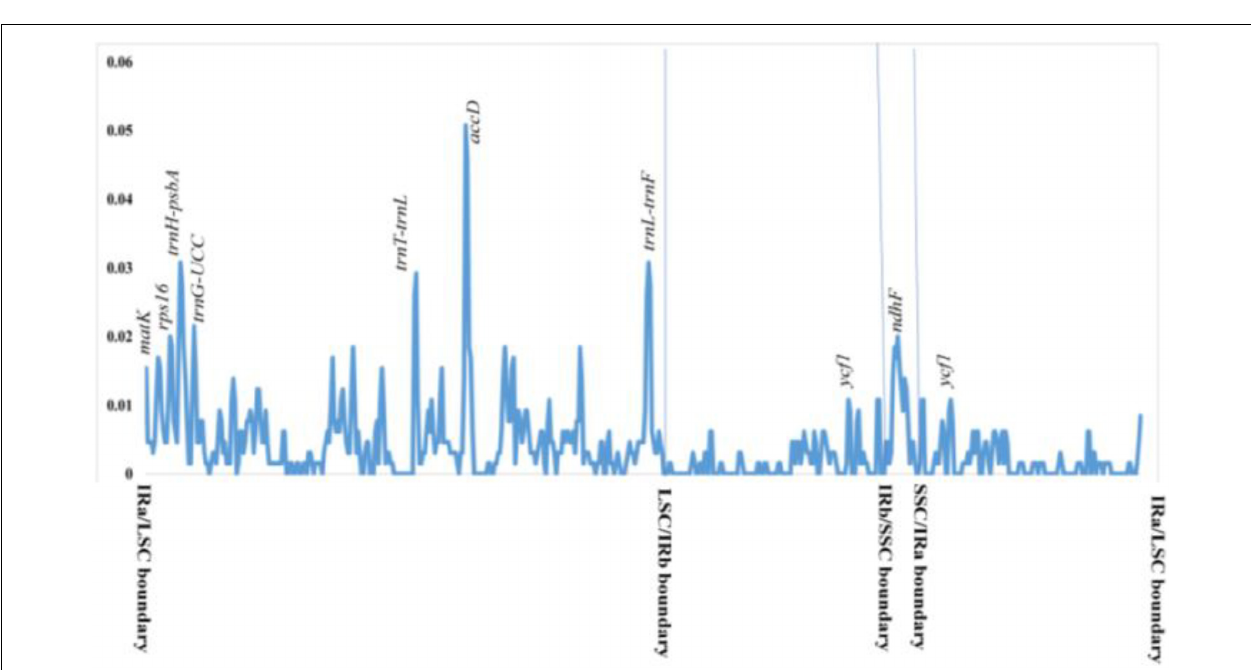
FIGURE 3 | Analyses of repeat sequences and SSRs in 31 Hoya group plastomes. (A) Frequency of the four repeat types. (B) Frequency of SSRs in LSC, SSC, and IR. (C) Frequency of SSRs in IGS and CDS. LSC, large single copy; SSC, small single copy; SSR, simple sequence repeats.